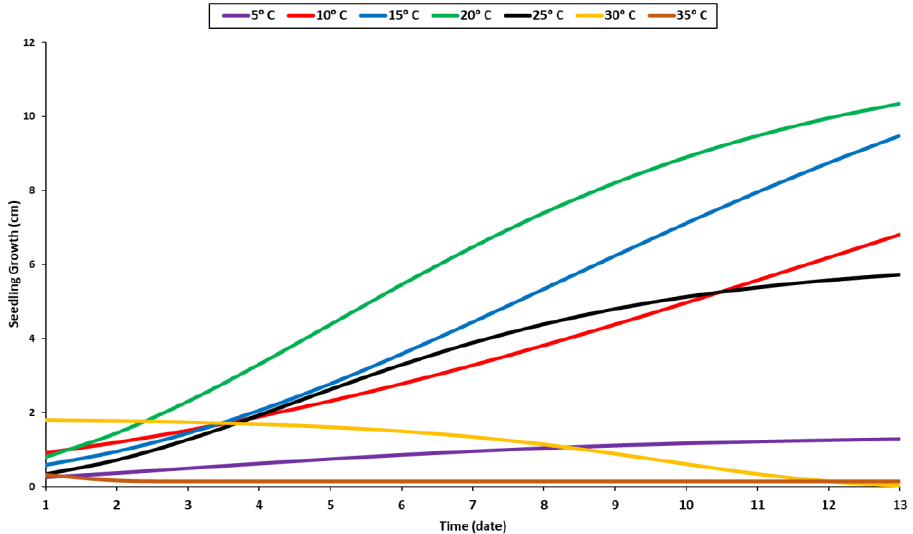
Figure 4. Growth response of seedlings to temperature levels.